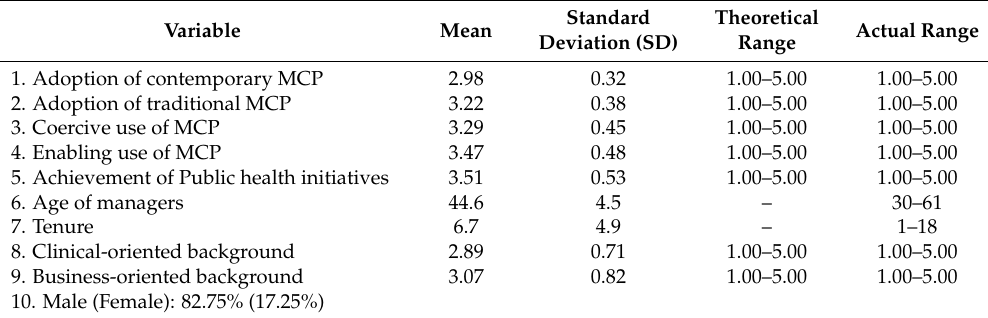
Table 3. Descriptive